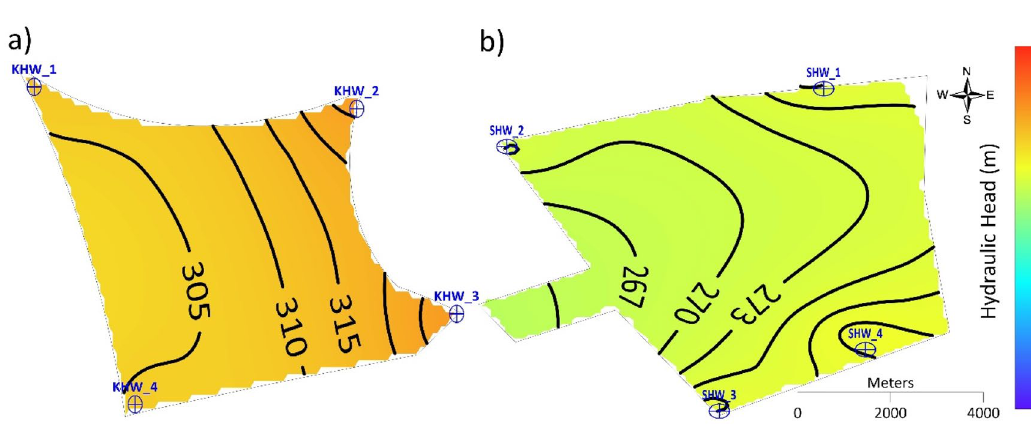
Figure 8. Simulated hydraulic head in 2030 for Scenario 2 at ( a ) Al-Khrair and ( b ) Al-Shuwaib sites.